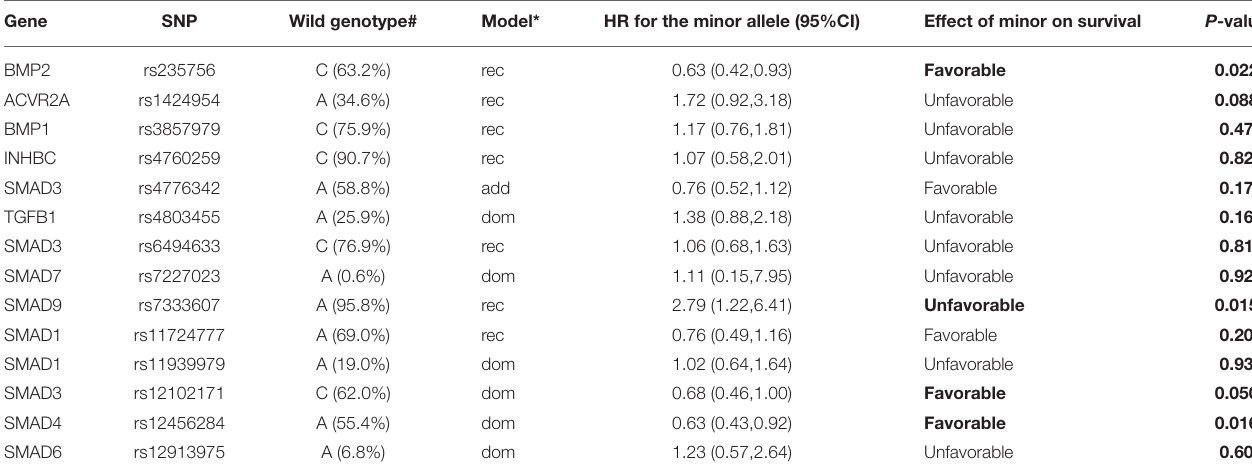
TABLE 2 | Genetic correlation with OS, univariate analysis ( N = 166